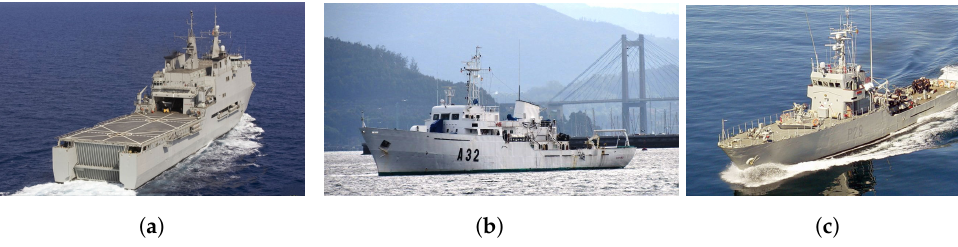
Figure 19. Measurement validation ships: ( a ) AAS“Castilla”; ( b ) HSS“Tofiño”; ( c )